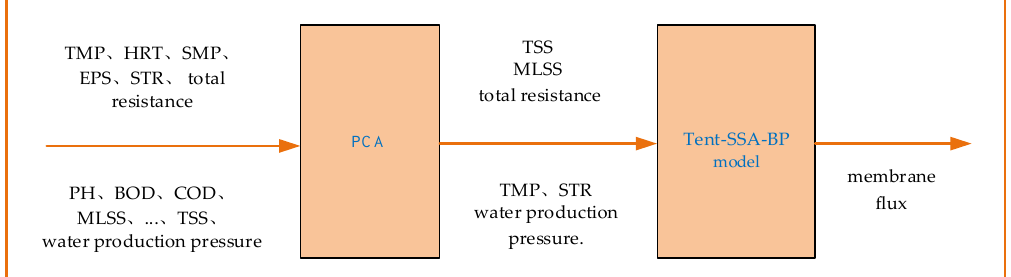
Figure 4. Membrane fouling prediction model.